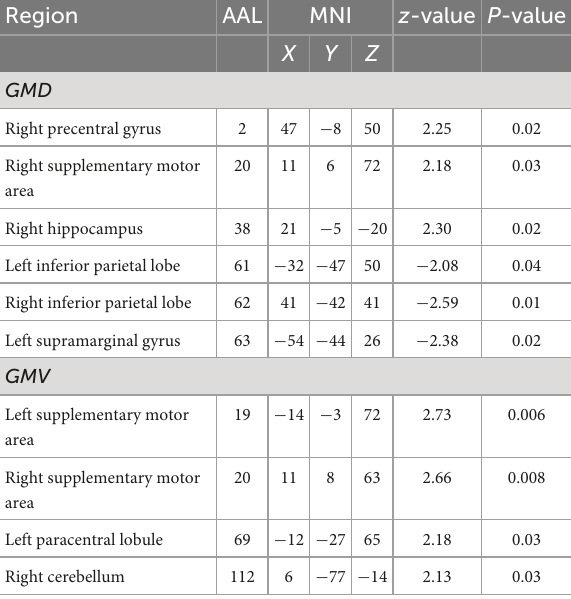
TABLE 3 Comparison of correlation between gray matter volume/density (GMV/GMD) and age. Region